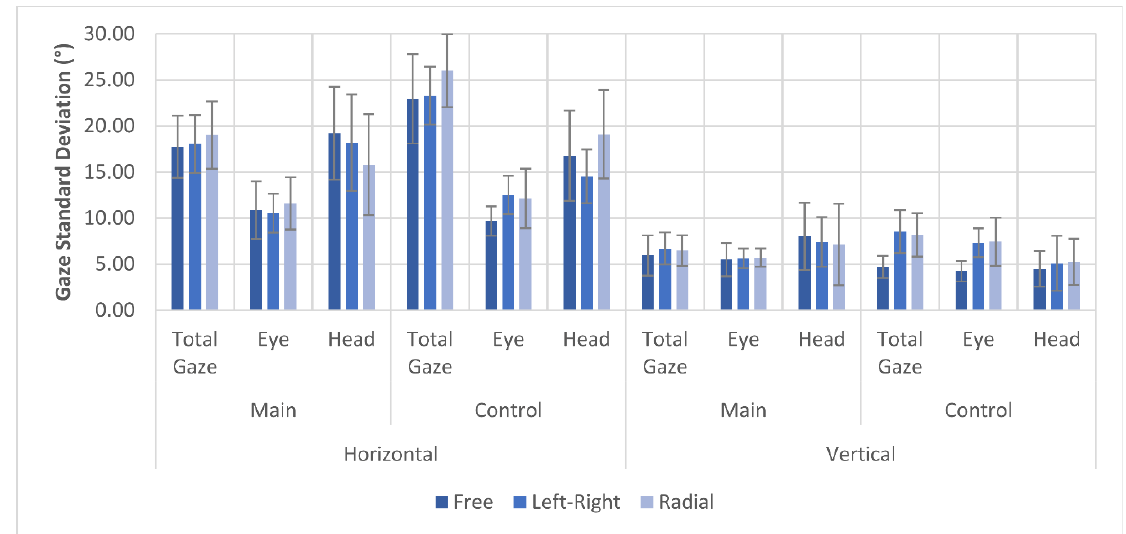
Figure 6. The average standard deviation of total gaze, eye position, and head rotation in the navigation task. Total gaze and head rotation were measured in reference to the estimated facing direction of the body.